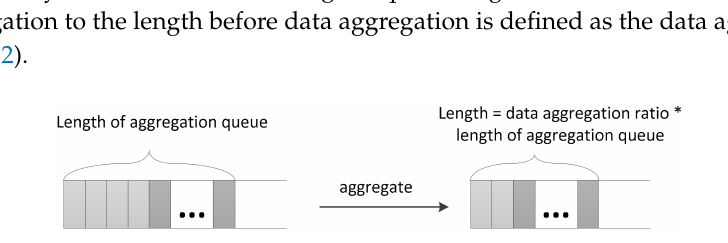
Figure 2. Length of the aggregation queue is reduced by